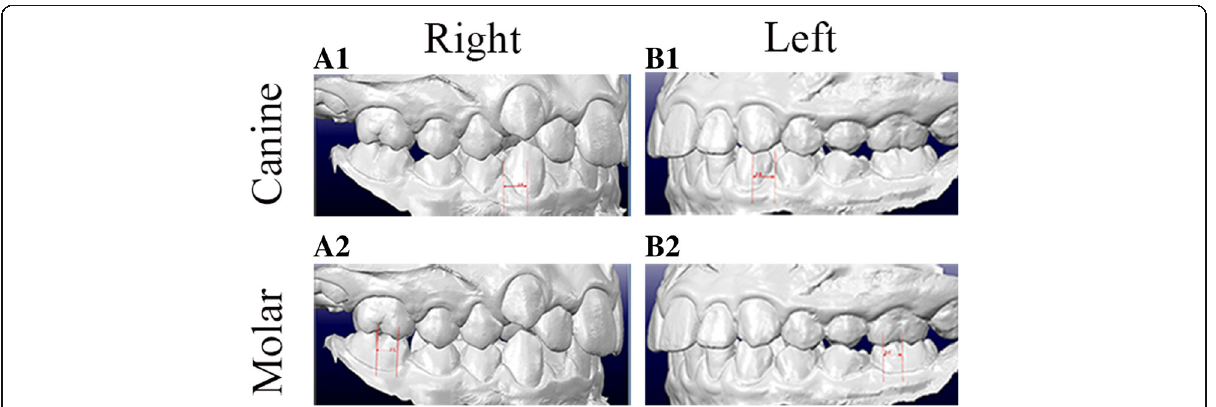
Fig. 2 Measurement of canine and molar relationship on digital study models . The reference surfaces for canine relationship were the interproximal contact point between mandibular canine and first premolar and the cusp of maxillary canine (A1 and B1); the reference surfaces for molar relationship measurement were the buccal groove of mandibular first molar and the mesiobuccal cusp of maxillary first molar (A2 and B2); The distances (millimeter) between the two reference surfaces of molar and canine were recorded separately for left and right sides in each